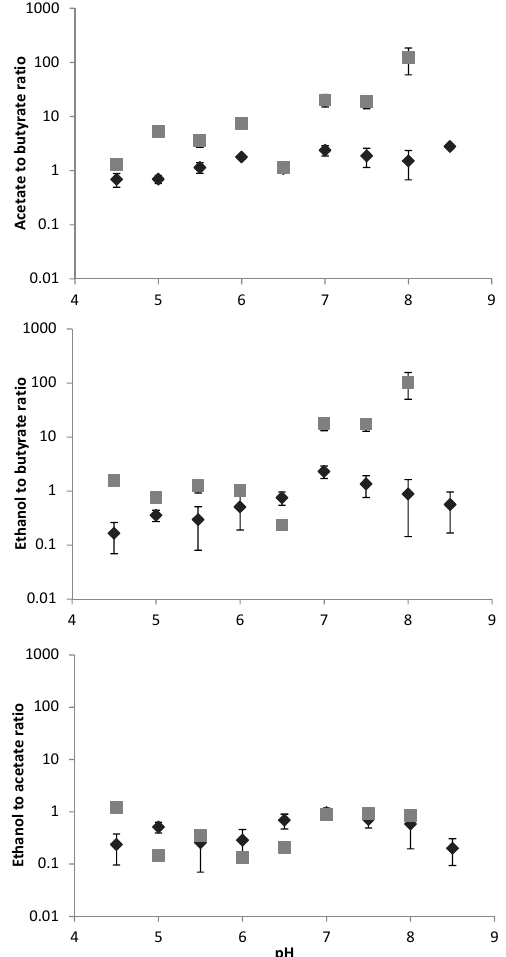
Figure 3. Influence of pH regulation approach on relative acetate:butyrate, ethanol:butyrate, and ethanol:acetate ratios for reset pH approach (grey square) and progressive pH approach (dark diamond) (Note: logarithmic scale).